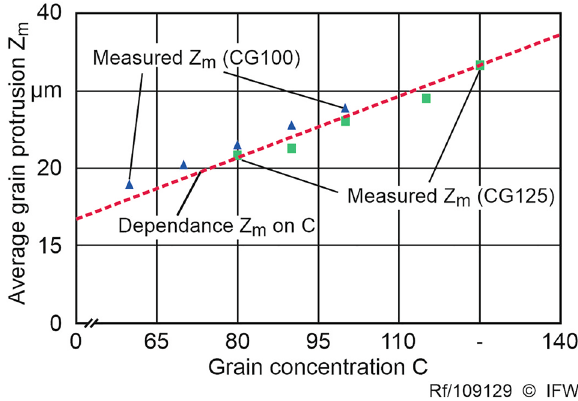
Fig. 10 Dependence of grain protrusion on the grain concentration for the CG100 and CG125 grinding wheels